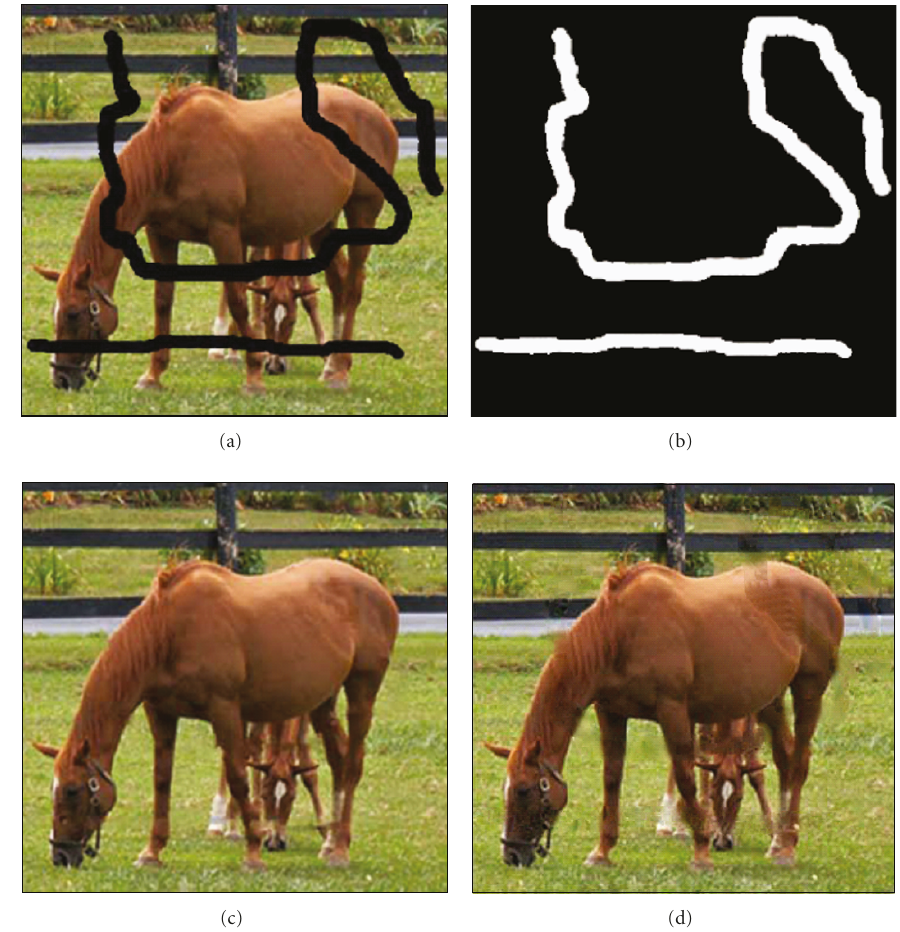
Figure 16: A given image for removal of artificially added scratches (a), the maskimage (b) the method in [18] (c), and the proposed method